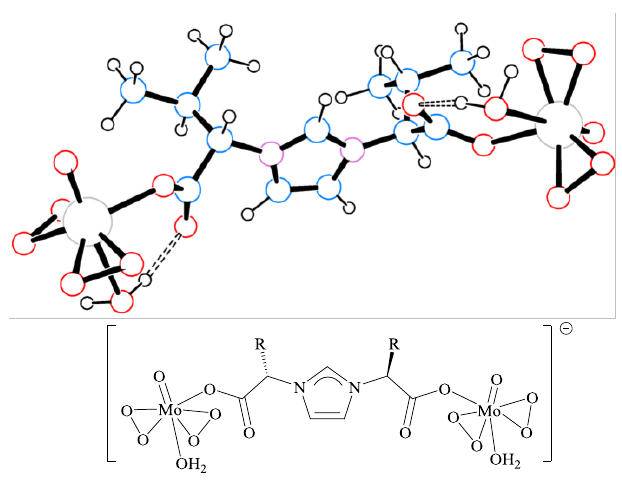
Figure 2. Optimized structure of the {[Mo(O)(O 2 ) 2 (H 2 O)] 2 (μ-L iPr )} − anion, 2c , and proposed formulation of the Mo catalyst species.